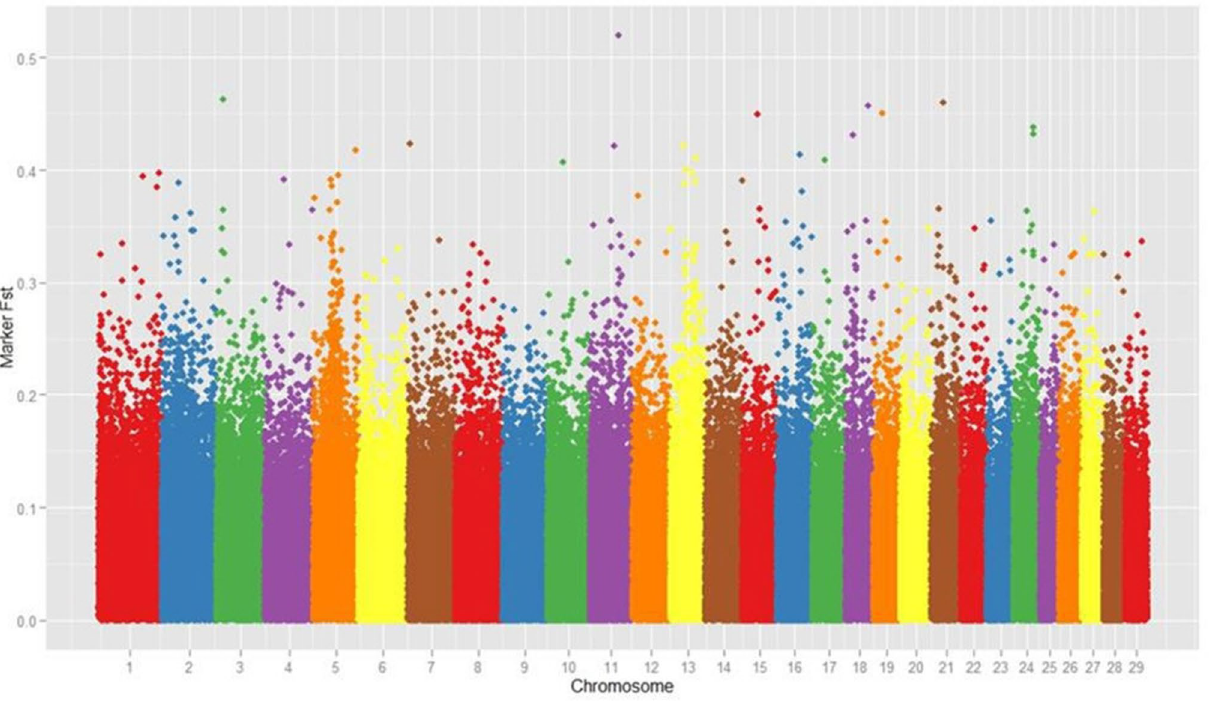
Figure 1. Distribution of marker F ST values across the chromosomes using Manhattan plot.